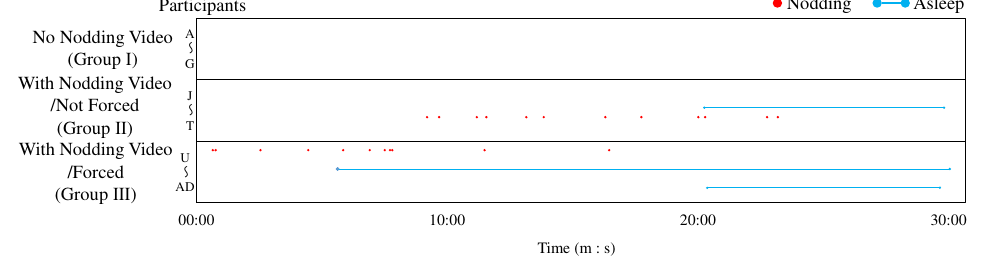
Figure 5. Time series data of nodding in the first half of the